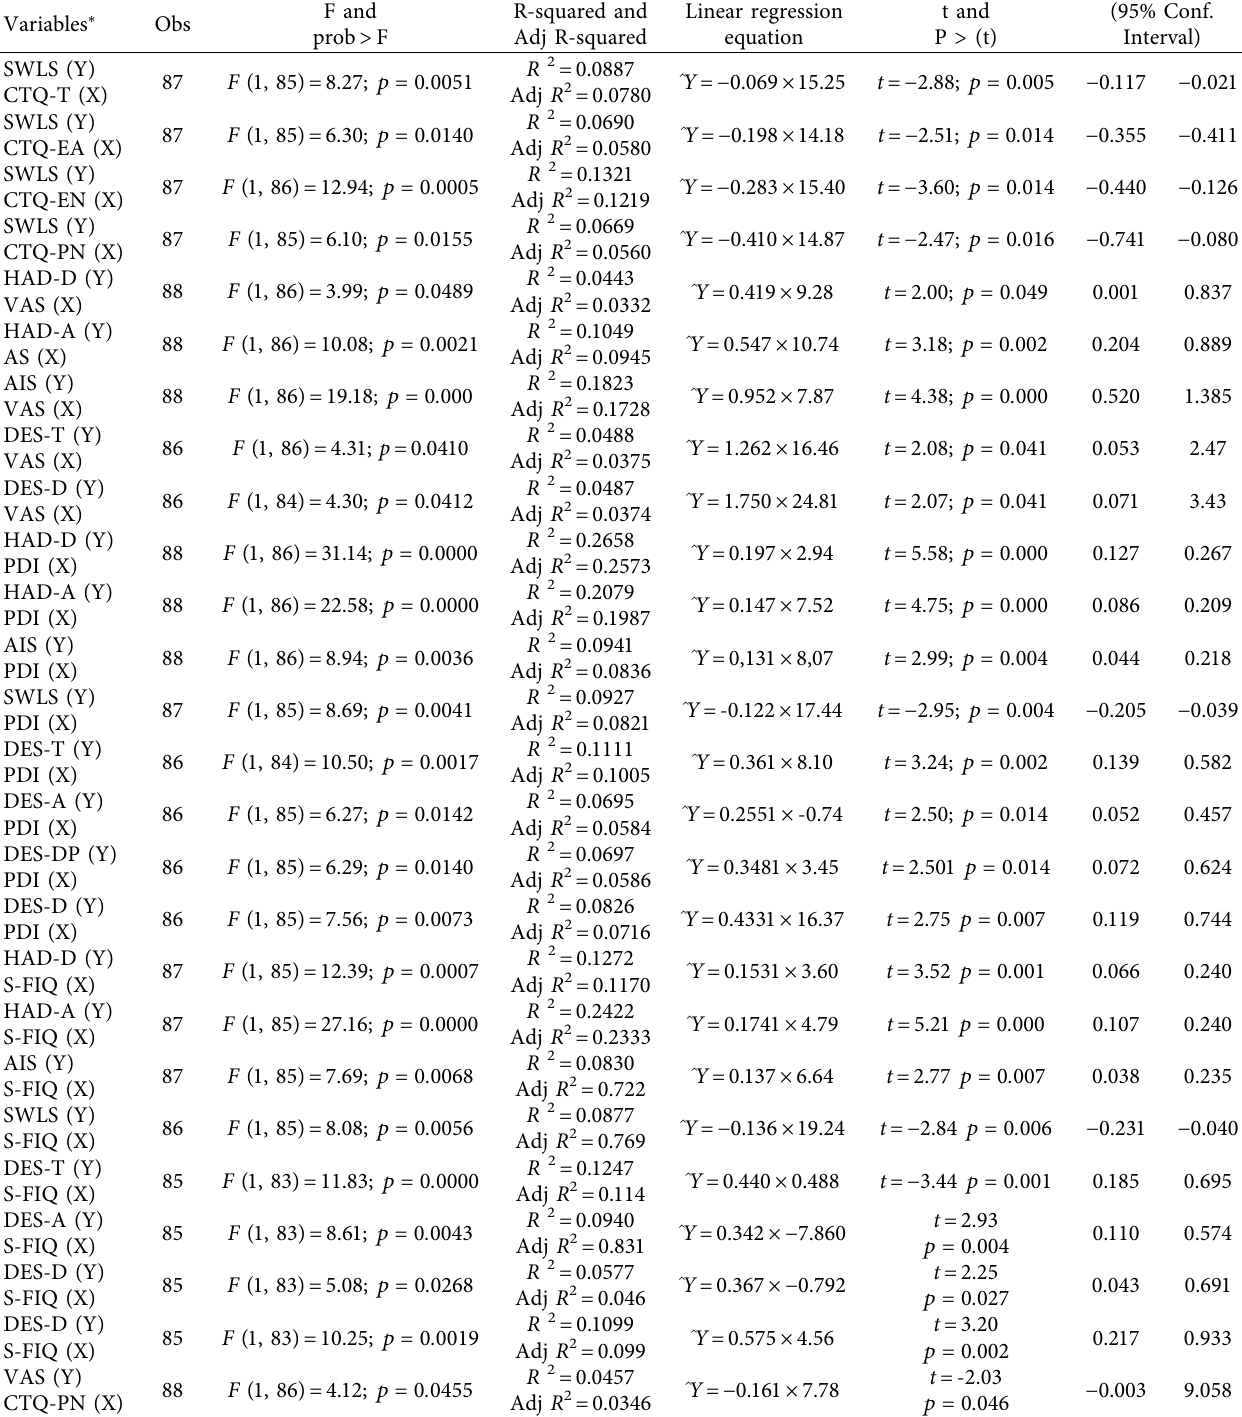
Table 4: Linear regression